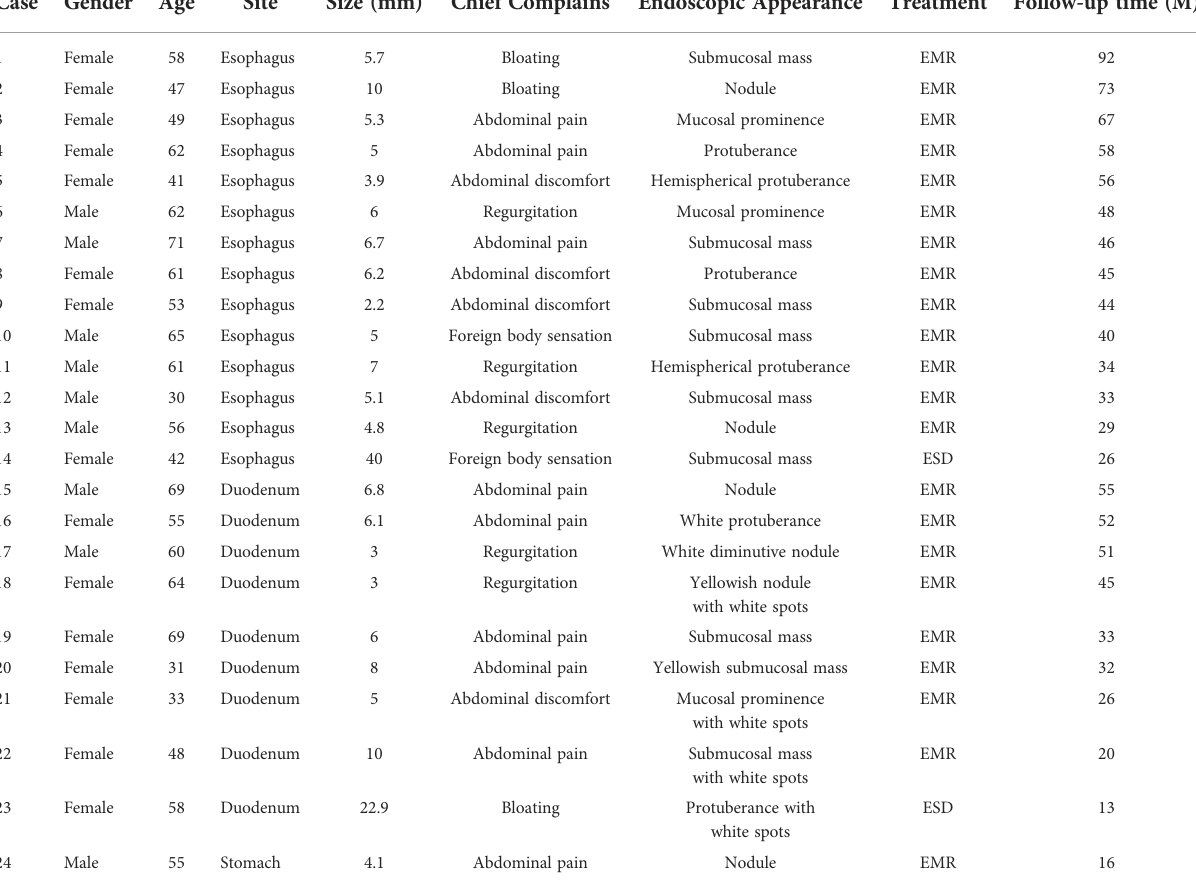
TABLE 1 Baseline